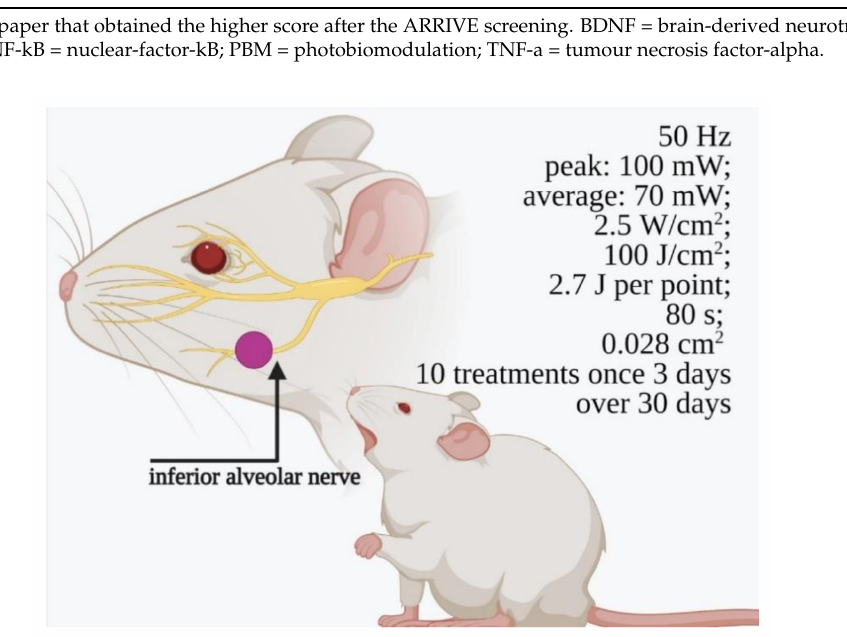
Figure 2. Design of the irradiation, site of irradiation and parameters, performed by Diker et al., [36] on a rat affected by an inferior alveolar nerve crush injury. Image created with